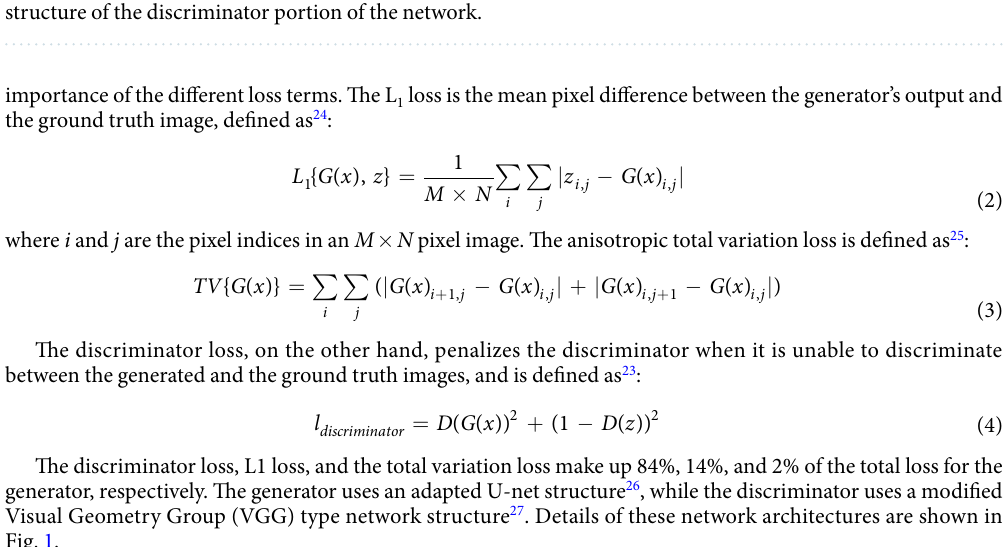
Figure 1. Diagram of the network structure. Every convolutional block is made up of two convolutional layers, each followed by a leaky rectified linear unit (ReLU) activation function. The second convolutional layer in each block changes the number of channels. ( a ) The structure of the generator portion of the network. ( b ) The structure of the discriminator portion of the